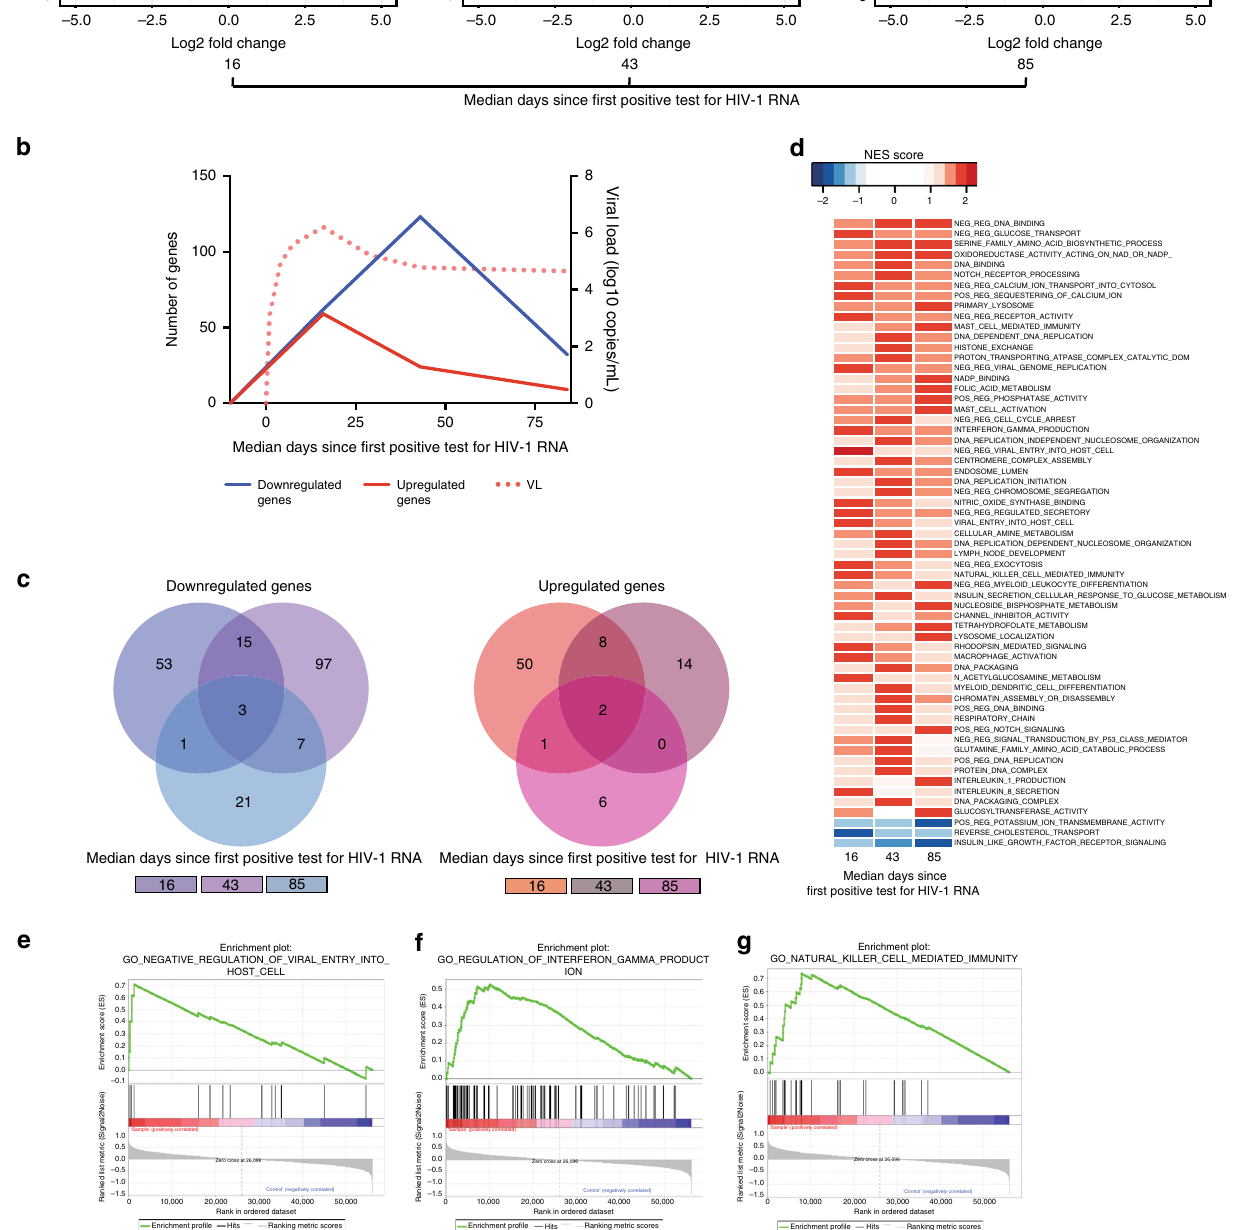
MAIT cell TCR repertoire diversi fi cation in acute infection . The MR1-restricted TCR repertoire of MAIT cells is limited, in particular for the TCR α chain while the β chain shows greater diversity. Nevertheless, controlled infections of humans with S. enterica was recently shown to lead to preferential expansion of the more antigen reactive MAIT cell clonotypes 44 . To evaluate possible alterations in the TCR repertoire of MAIT cells resulting from acute HIV-1 infection, we analyzed the TCR